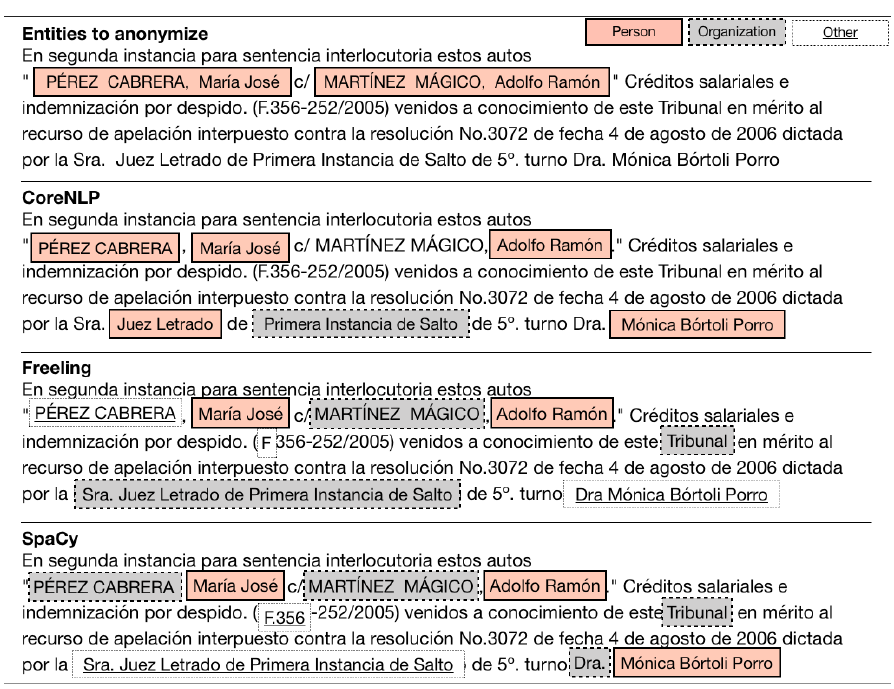
Figure 2. NER analysis by CoreNLP, Freeling and SpaCy over a document of our